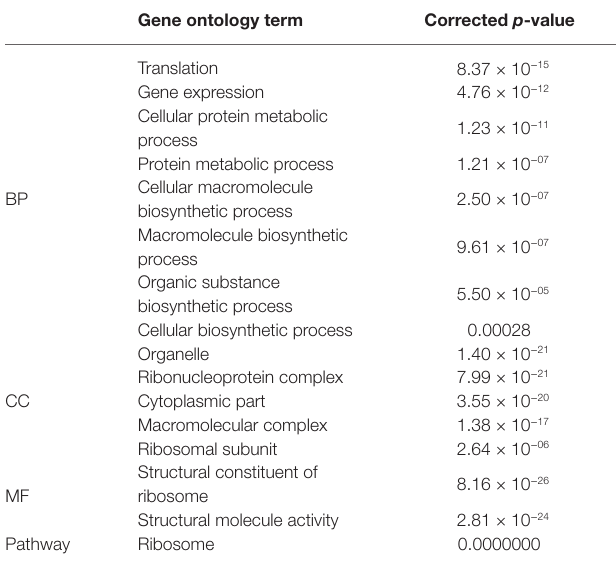
TABLE 2 | GO and pathway enrichment analysis of B vs. A. Gene ontology